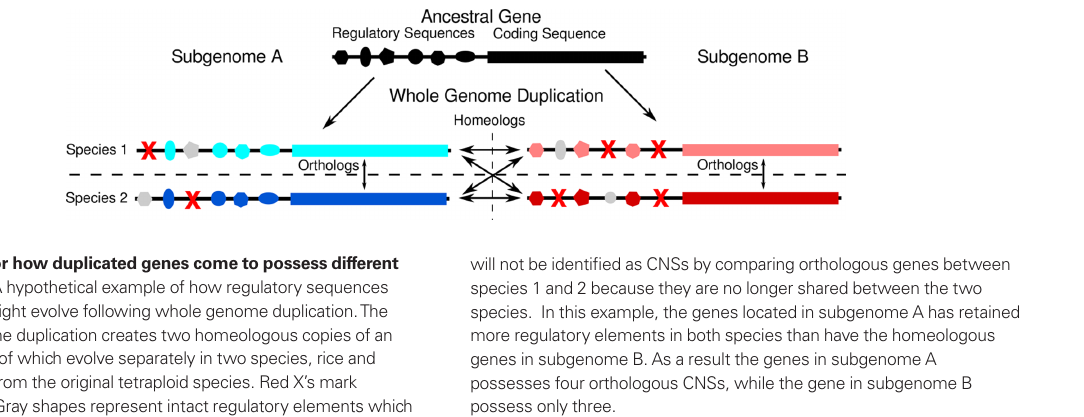
will not be identified as CNSs by comparing orthologous genes between species 1 and 2 because they are no longer shared between the two species. In this example, the genes located in subgenome A has retained more regulatory elements in both species than have the homeologous genes in subgenome B. As a result the genes in subgenome A possesses four orthologous CNSs, while the gene in subgenome B possess only three.